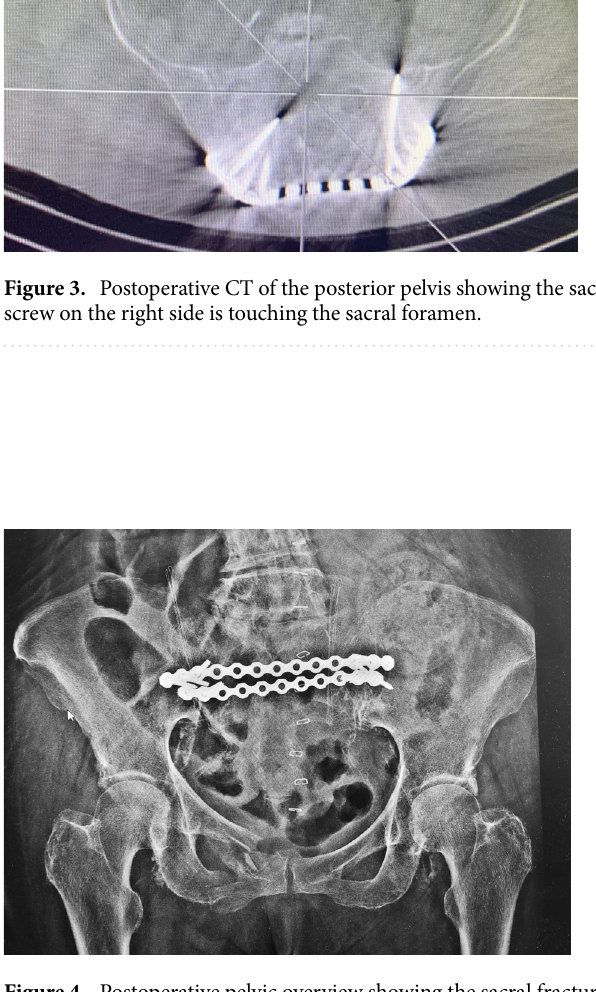
Figure 4. Postoperative pelvic overview showing the sacral fracture fixed with 2 ilioiliac